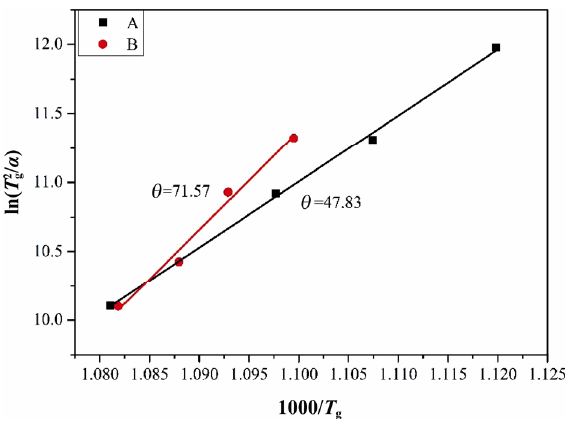
Fig. 4 ln( T g2 / α ) versus 1000/ T g for A and B glass.